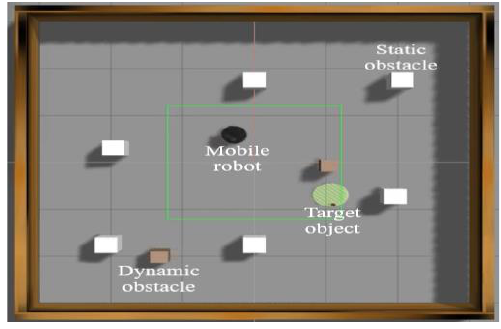
Figure 7. DQN simulation in the Gazebo.